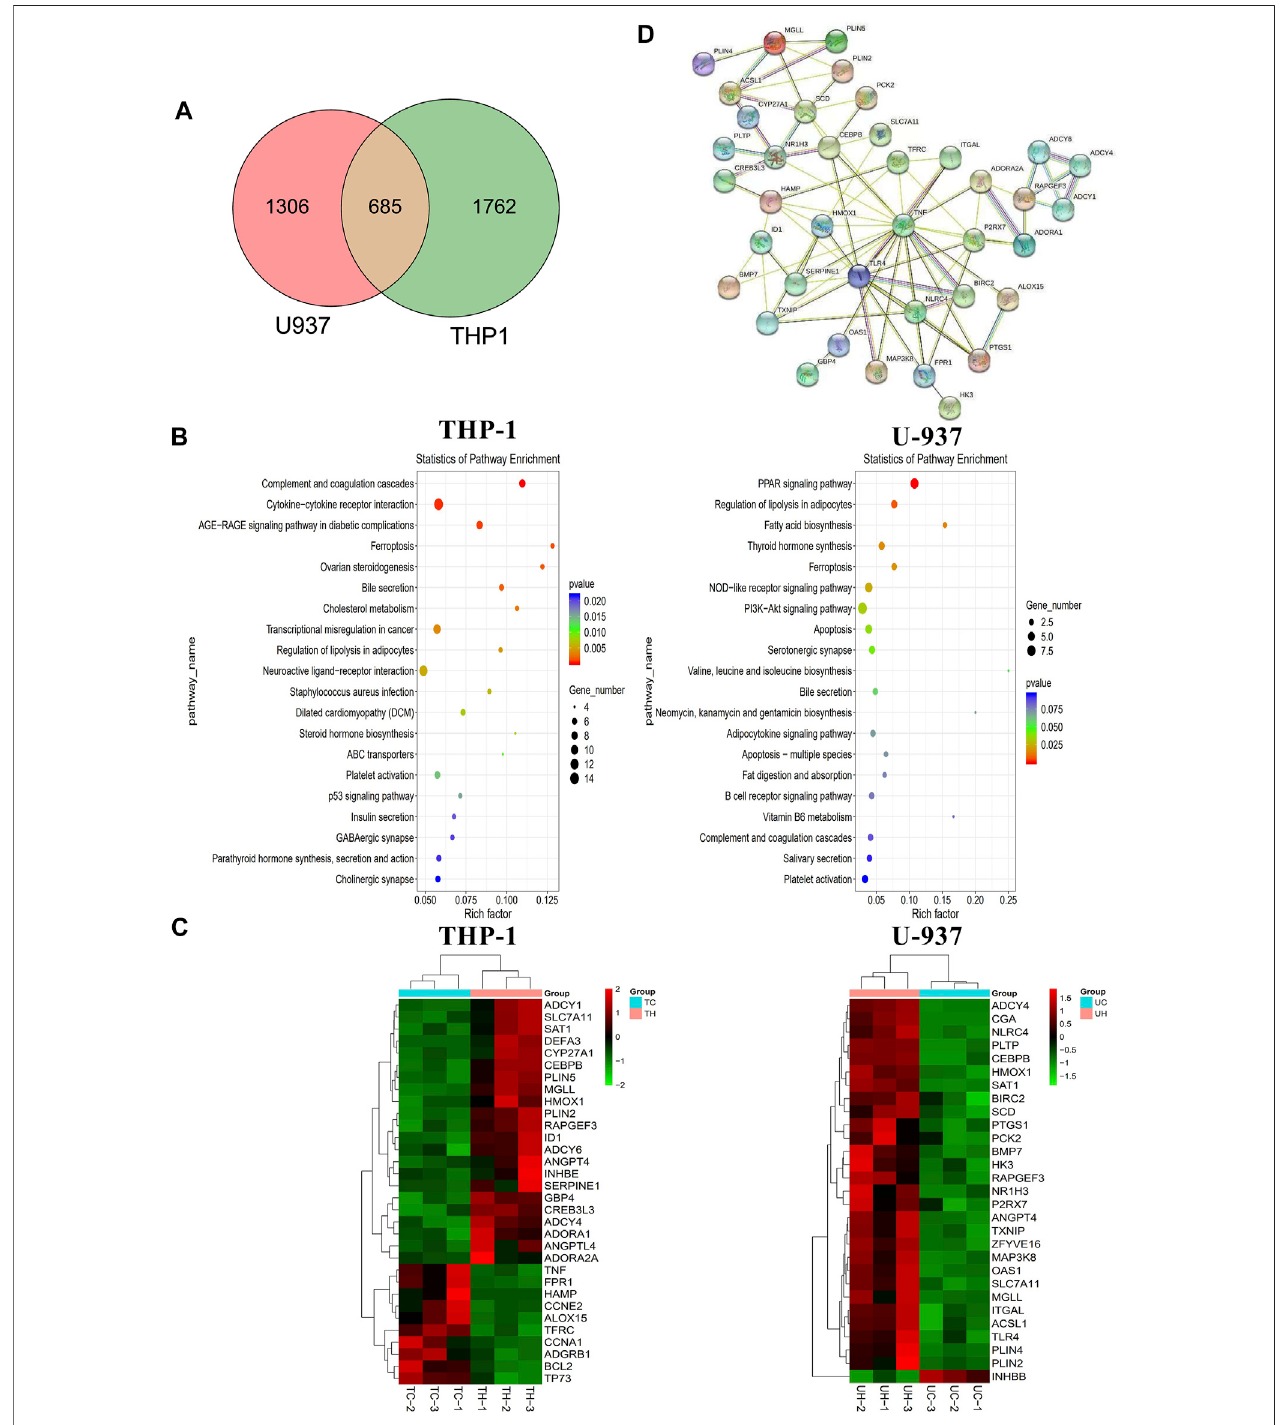
FIGURE 5 | The mechanism of the inhibitory effect of honokiol on THP-1 and U-937 cells. (A) Venn diagram. (B) KEGG pathway analyses of all differentially expressed genes. (C) Heatmap of the partial differentially expressed genes. (D) Protein-Protein interaction (PPI) Network diagram.